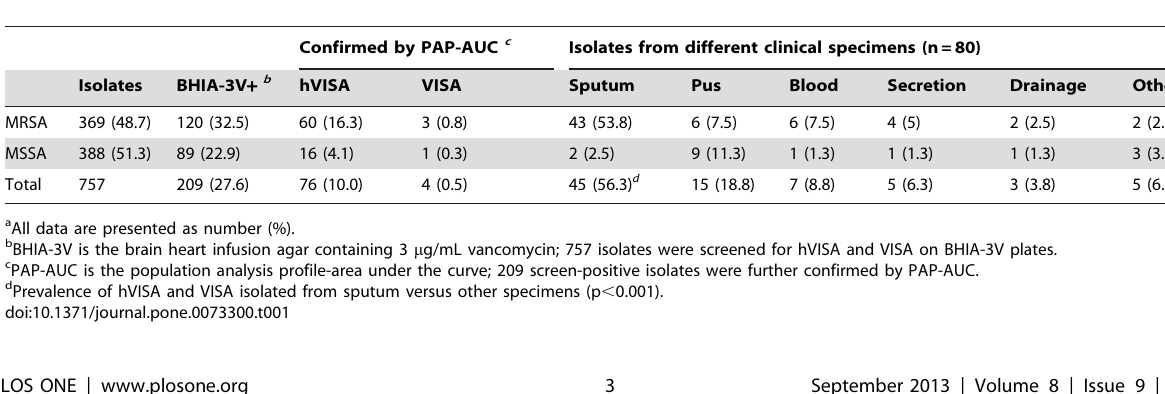
Table 1. All hVISA and VISA isolates identified from different clinical specimens a .